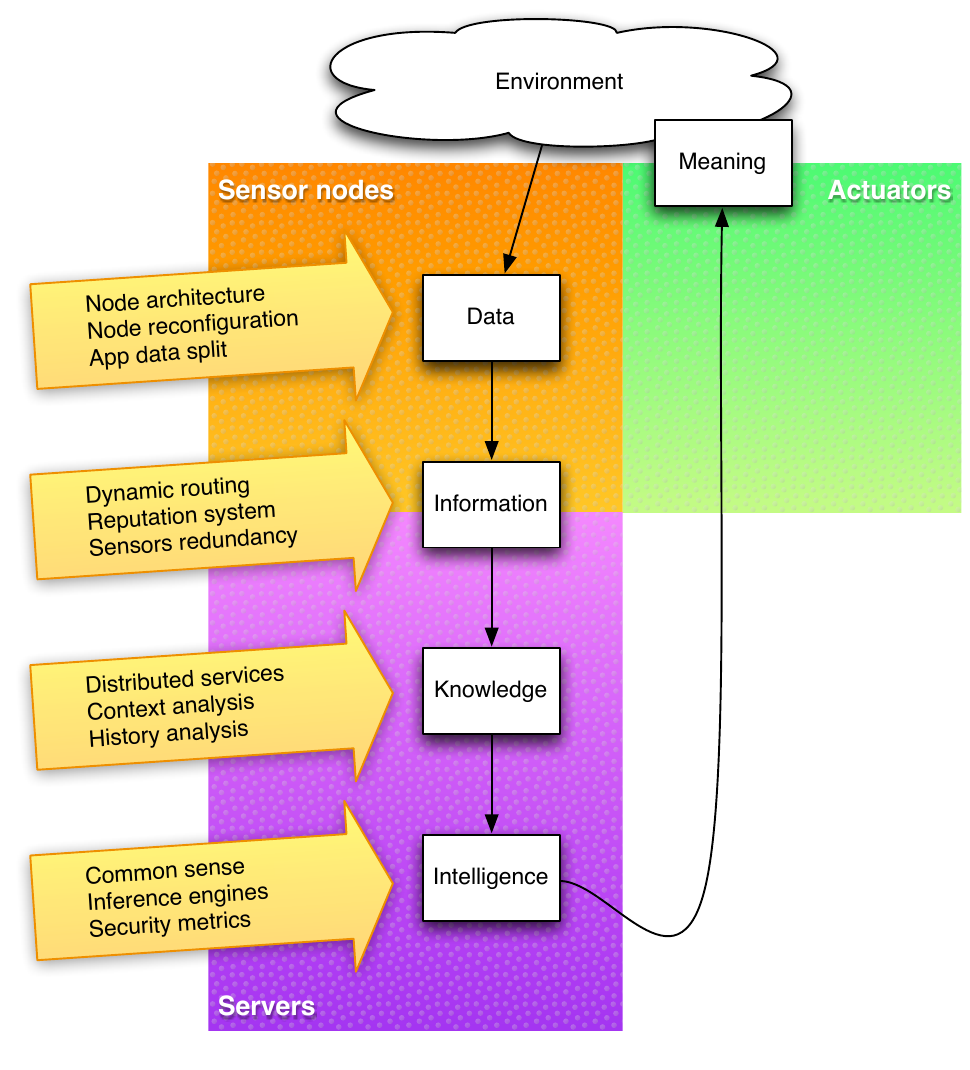
Figure 1. Overview of the data processing flow in an intelligent environment and the security measures we